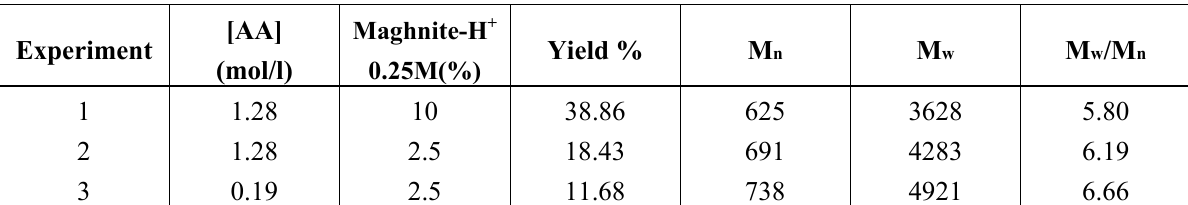
Table 2. Polycondensation of THF with maleïc anhydride induced by “Maghnite-H + 0.25M”